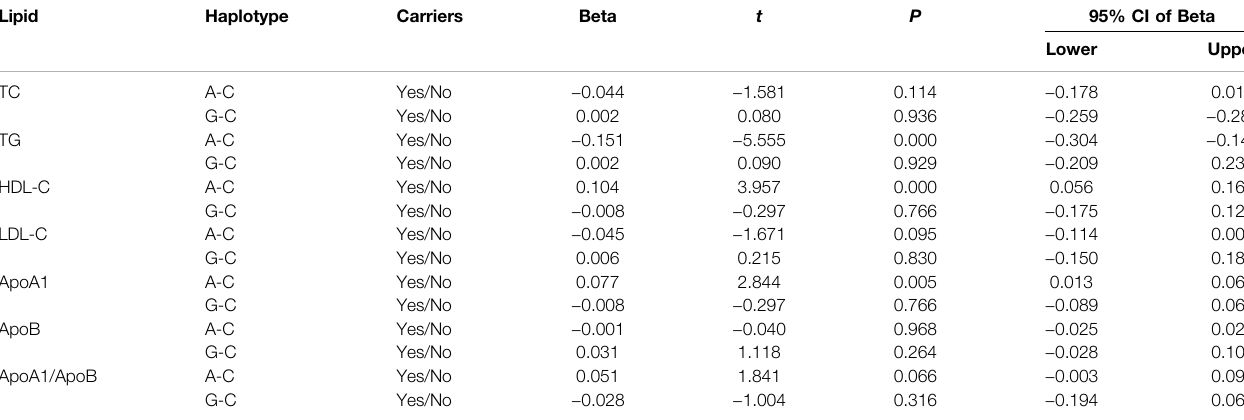
TABLE 6 | Associations between EHBP1 haplotypes and serum lipid levels in the controls. Lipid